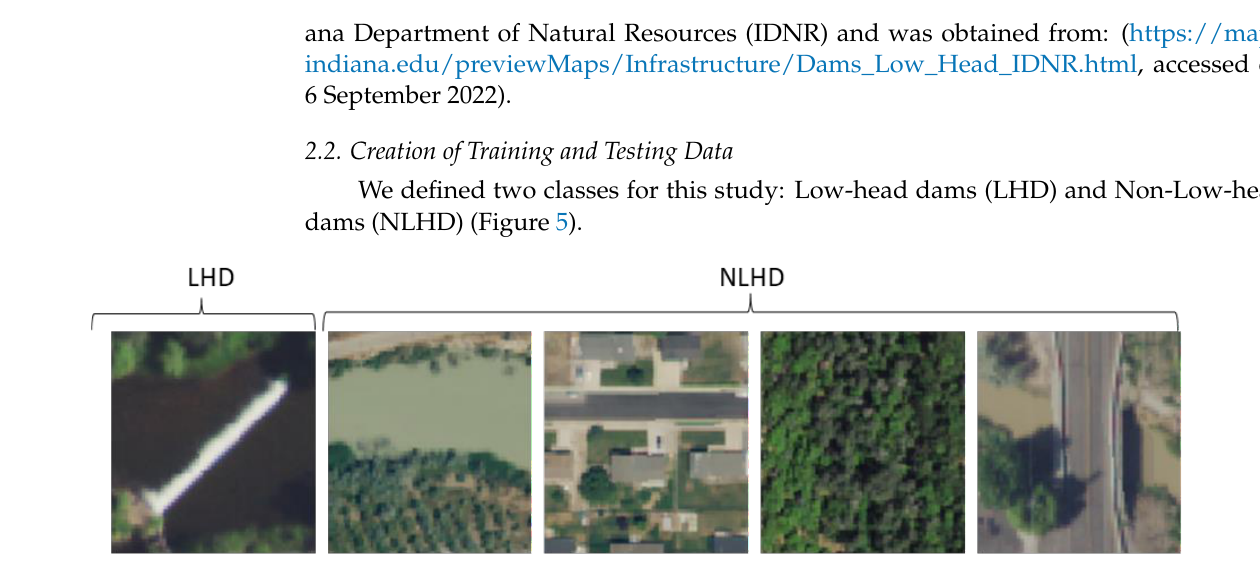
Figure 5. LHD and NLHD classes.